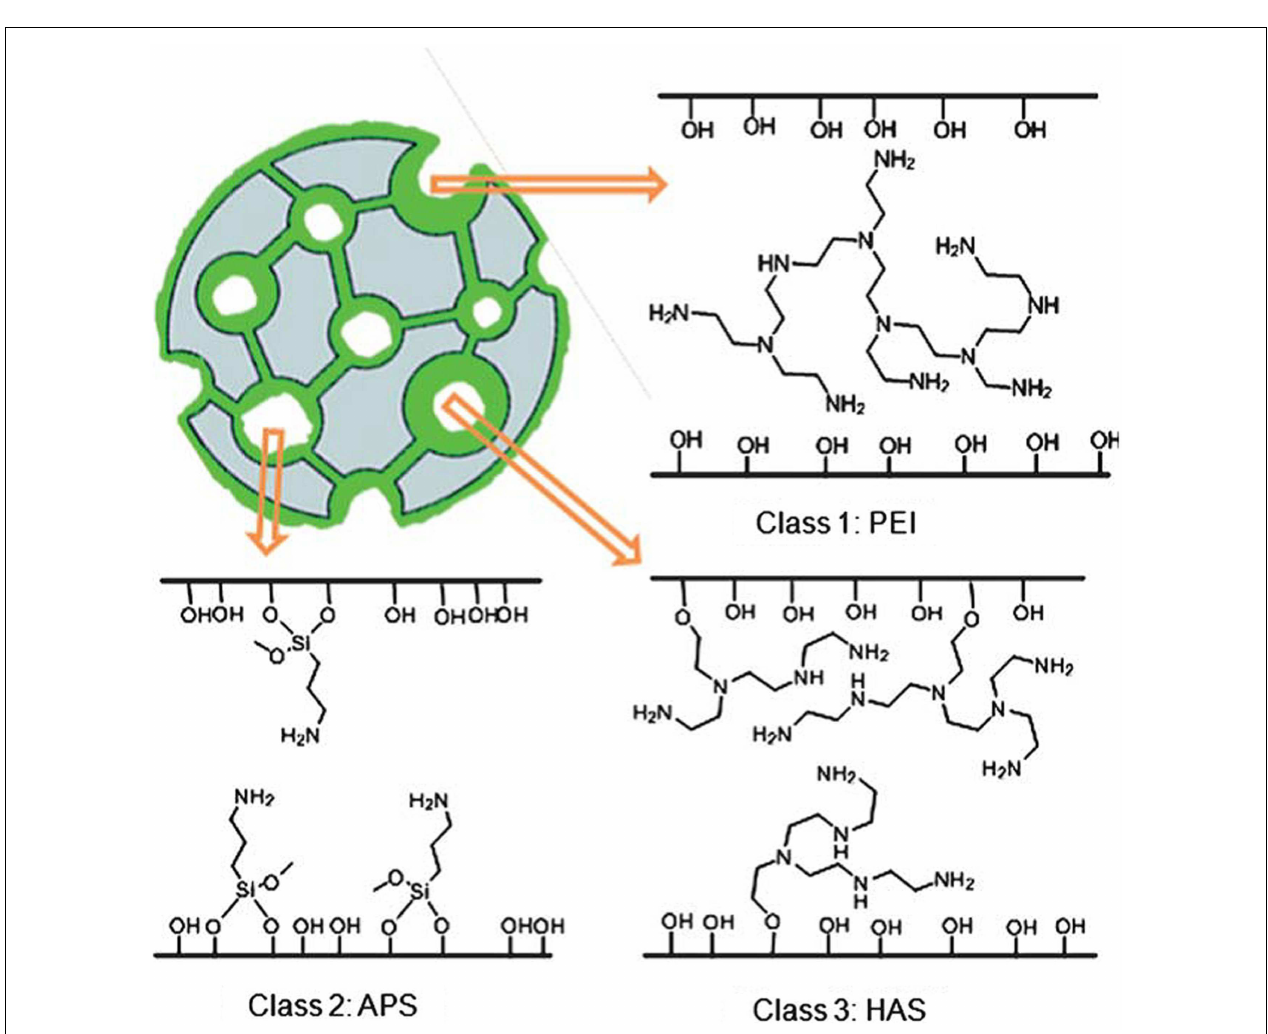
FIGURE 7 | Classification of immobilized amine adsorbents, reproduced from Bollini et al. (2011)